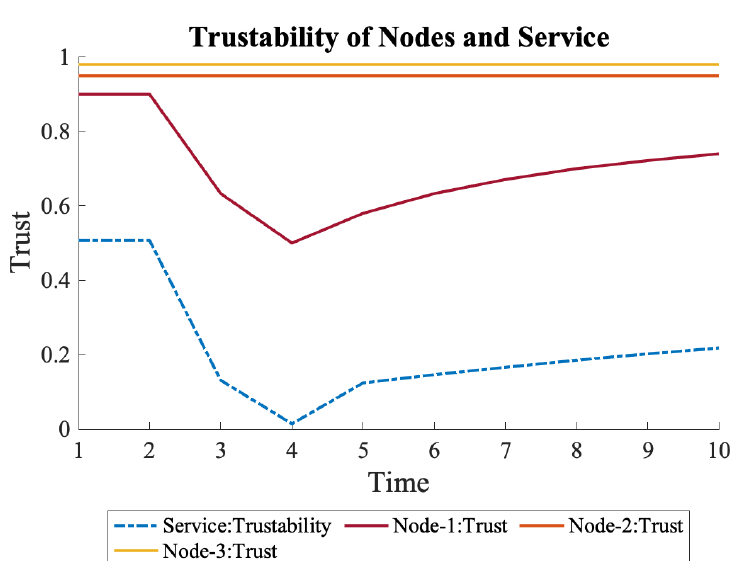
Figure 12. If the trust declines rapidly for a short period of time, overall trustability also declines but does not recover